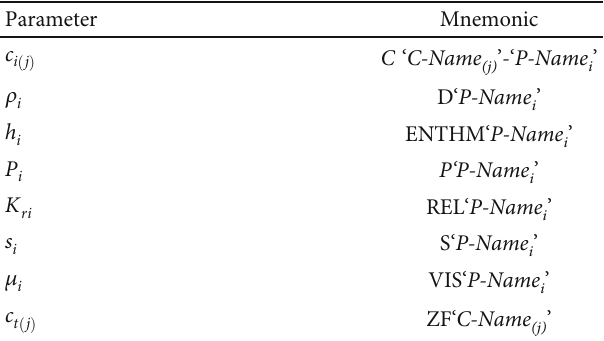
Table 6: Additional MUFITS mnemonics associated with the USEREOS option.